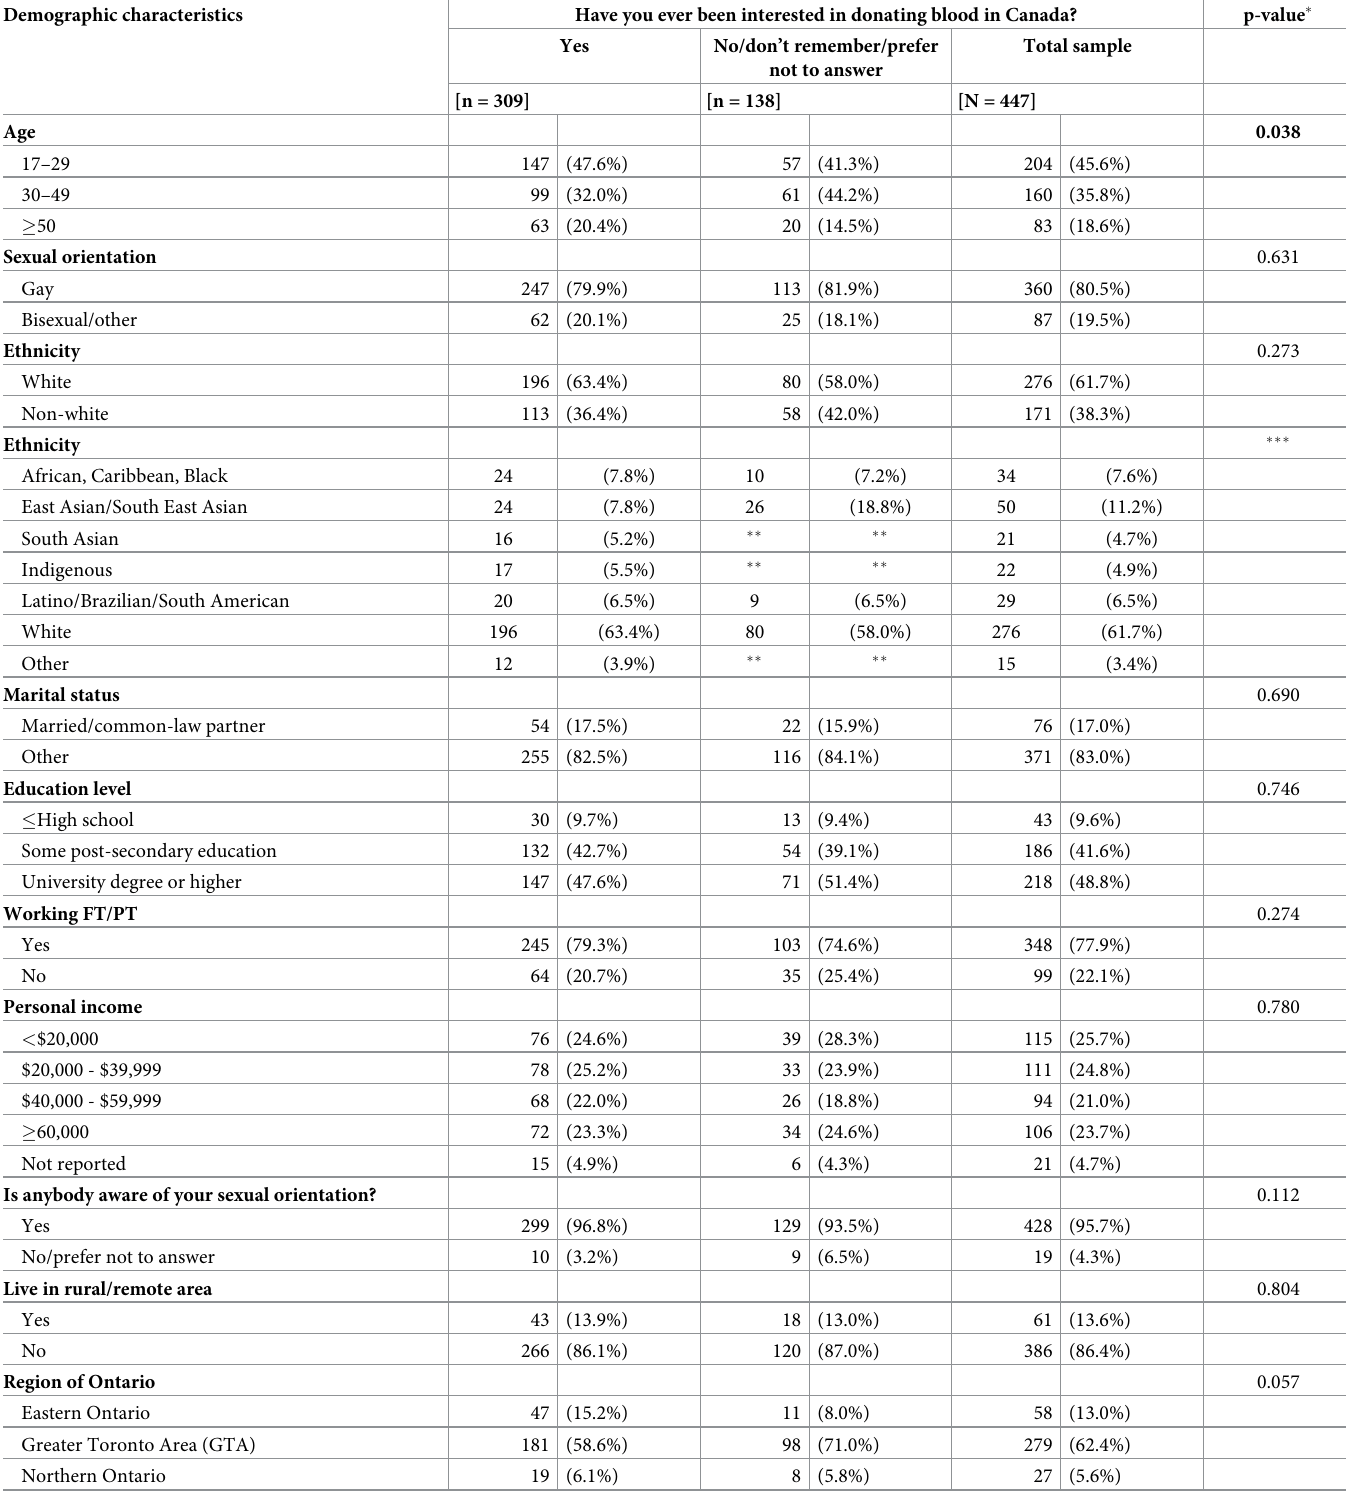
Table 1. Demographic characteristics of participants by interest in donating blood. Demographic